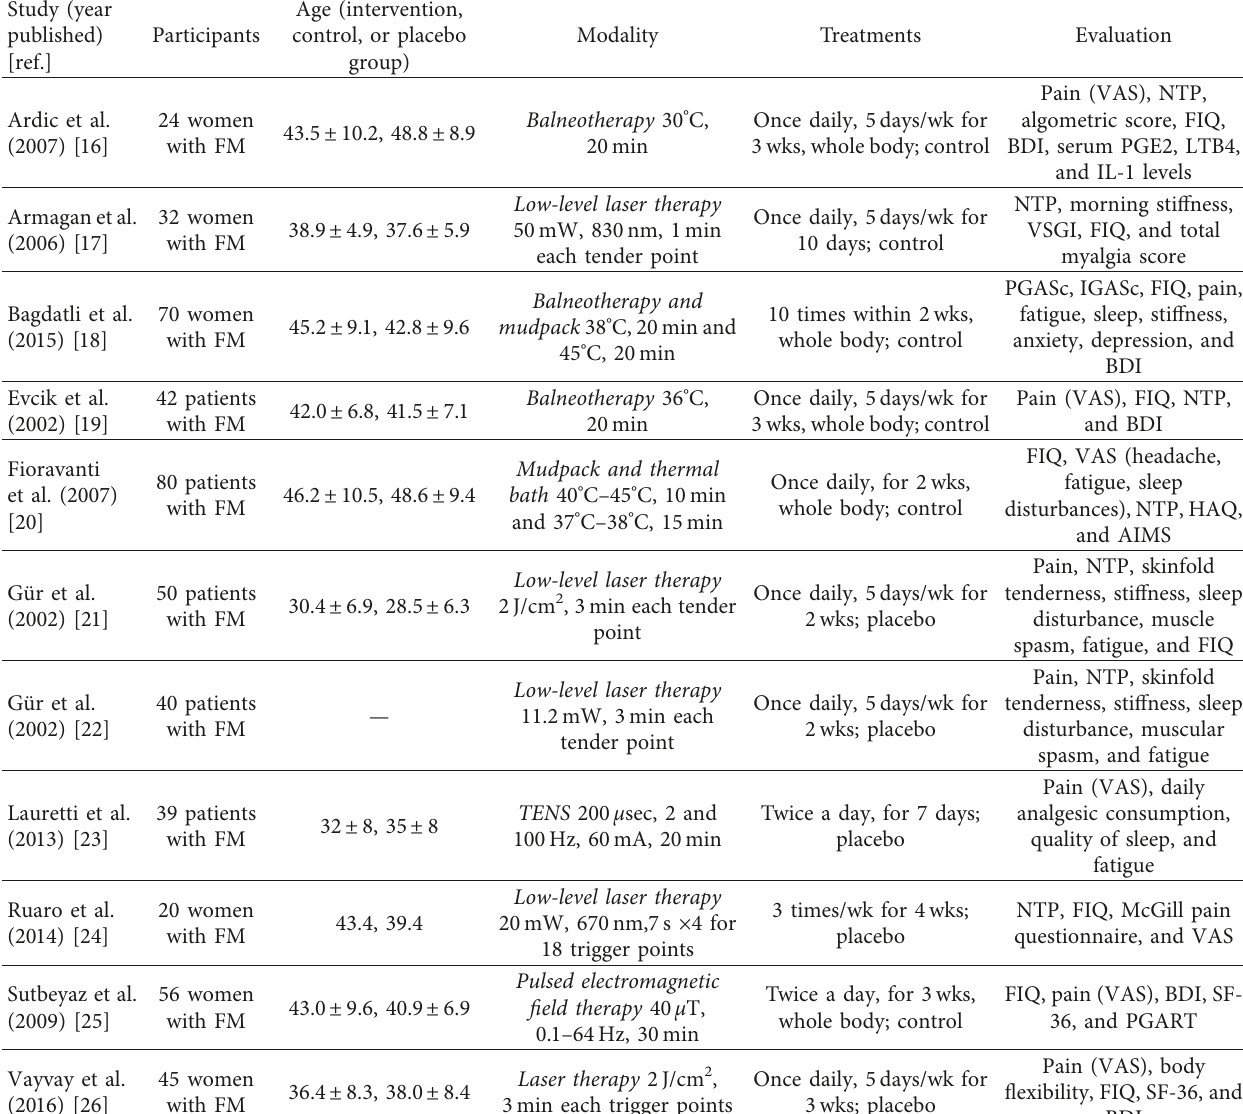
Table 2: Characteristics of the studies’ participants and